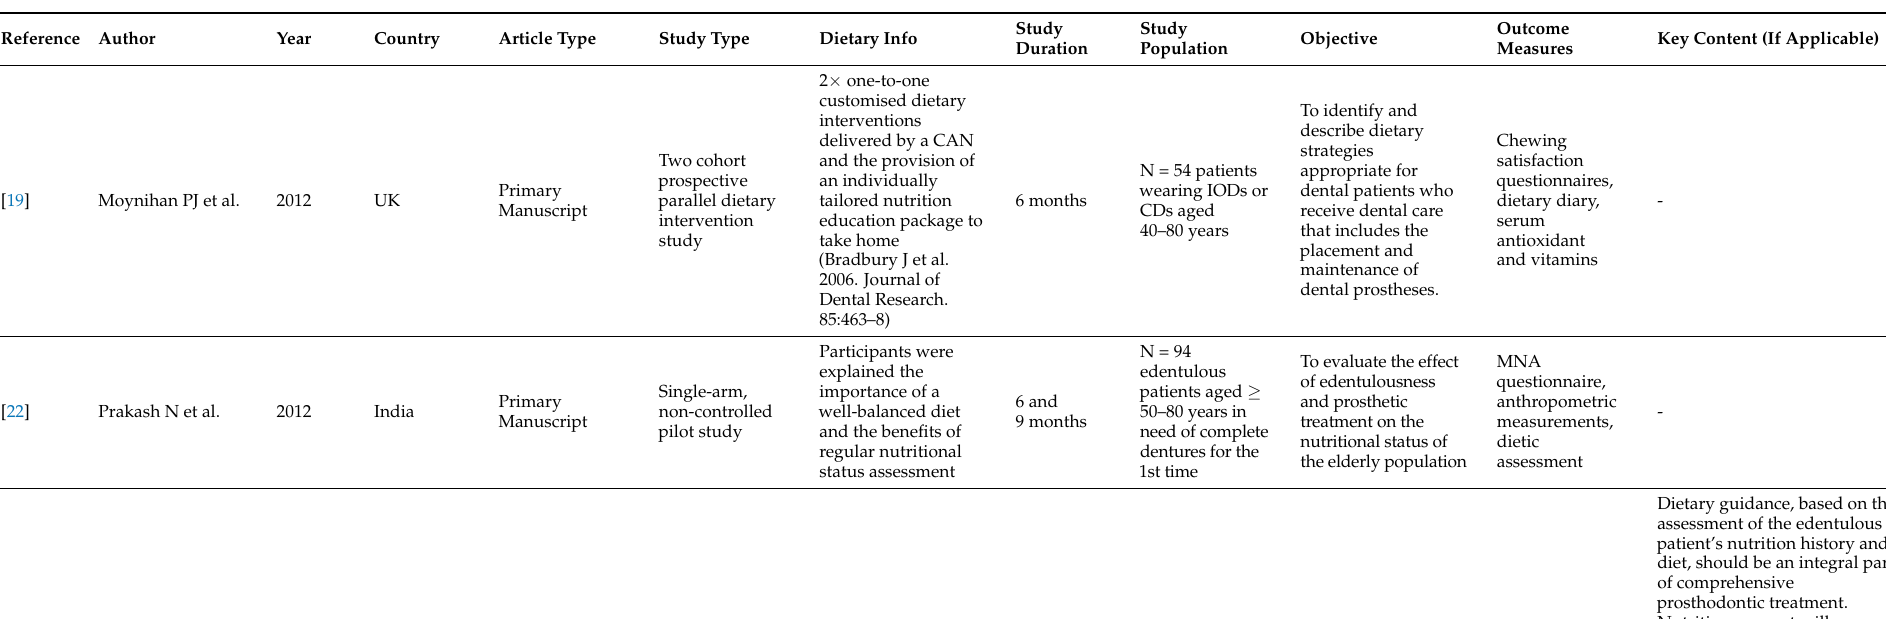
Table A1. Data charting form for peer reviewed